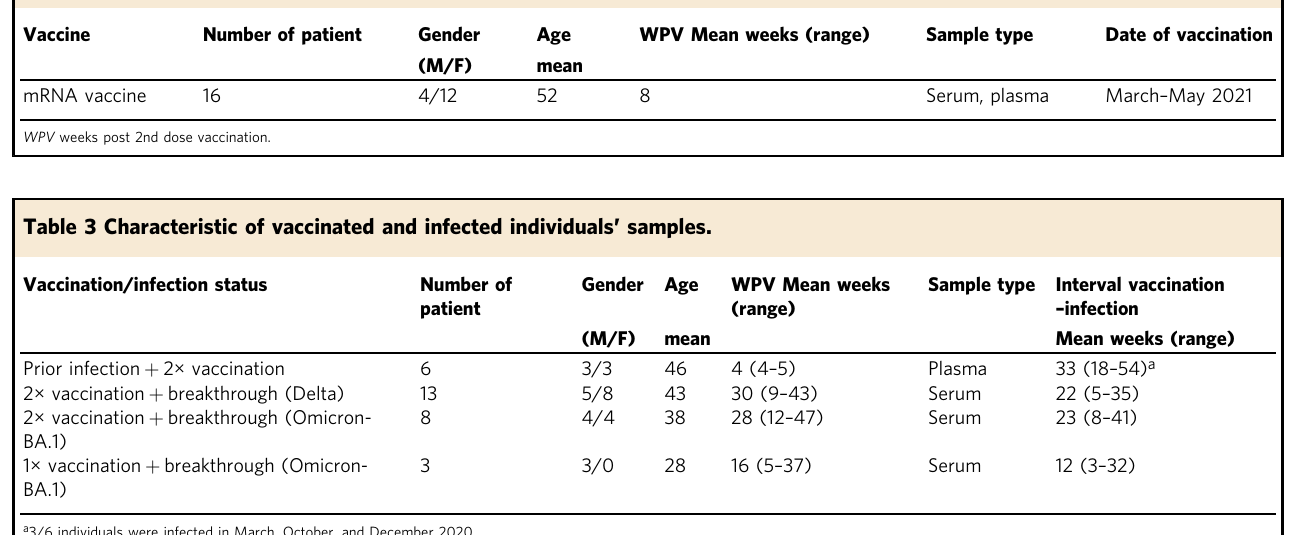
Table 2 Characteristic of vaccinated individuals ’